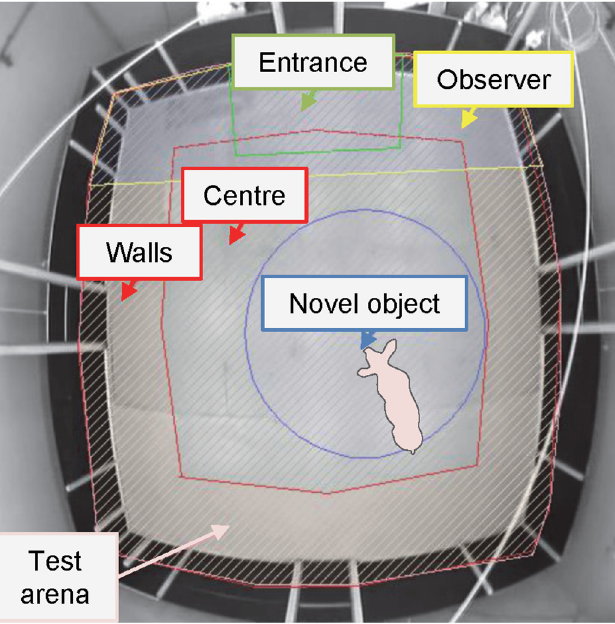
Fig 1. Zones in the open field and novel object tests. The zones were defined using the Ethovision XT 10 video tracking software to perform a posteriori analyses of locomotion patterns in the